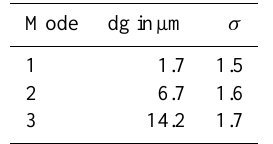
Table 2. Statistical parameters for mineral dust particles after Al- faro and Gomes